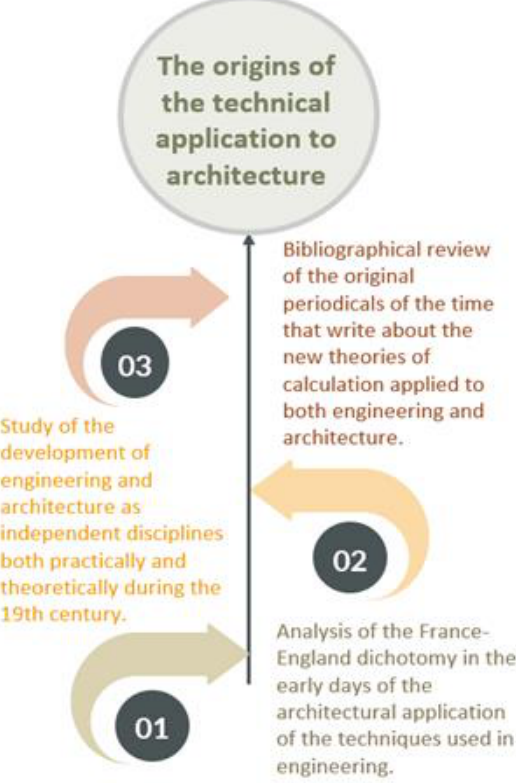
Figure 1. Research Figure 1. Research objectives .